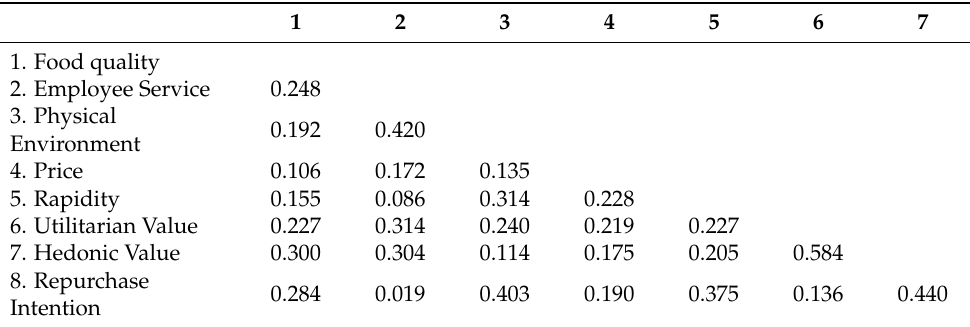
Table 3. Correlation